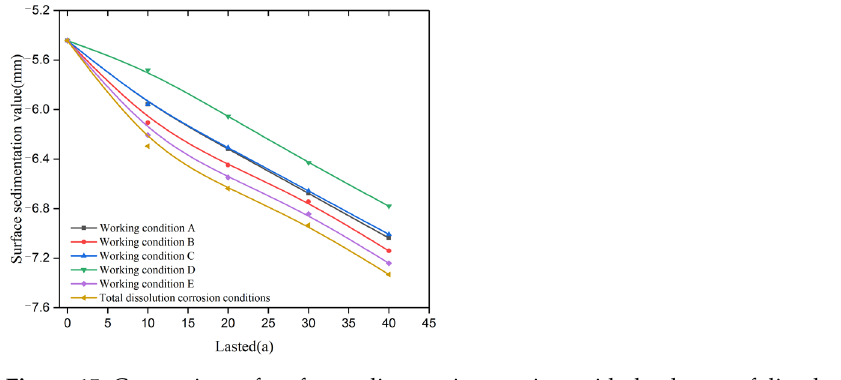
Figure 15. Comparison of surface sedimentation maxima with the degree of dissolution.